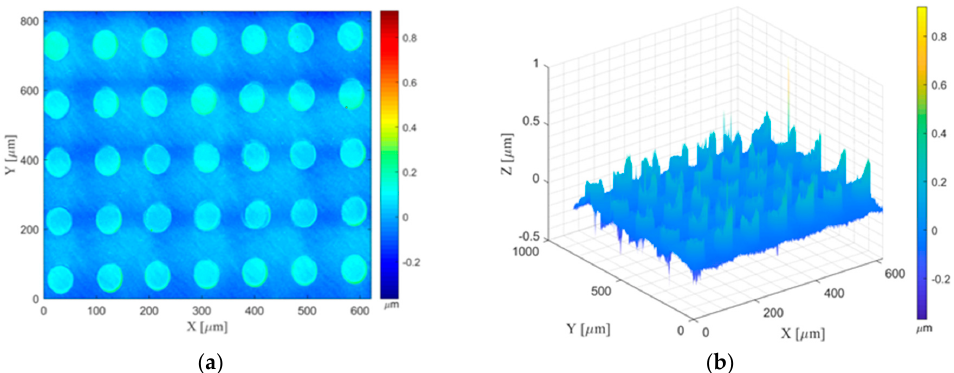
Figure 3. Surface reconstruction after rotation of the raw measured surface: ( a ) 2D contour and ( b ) 3D surf.